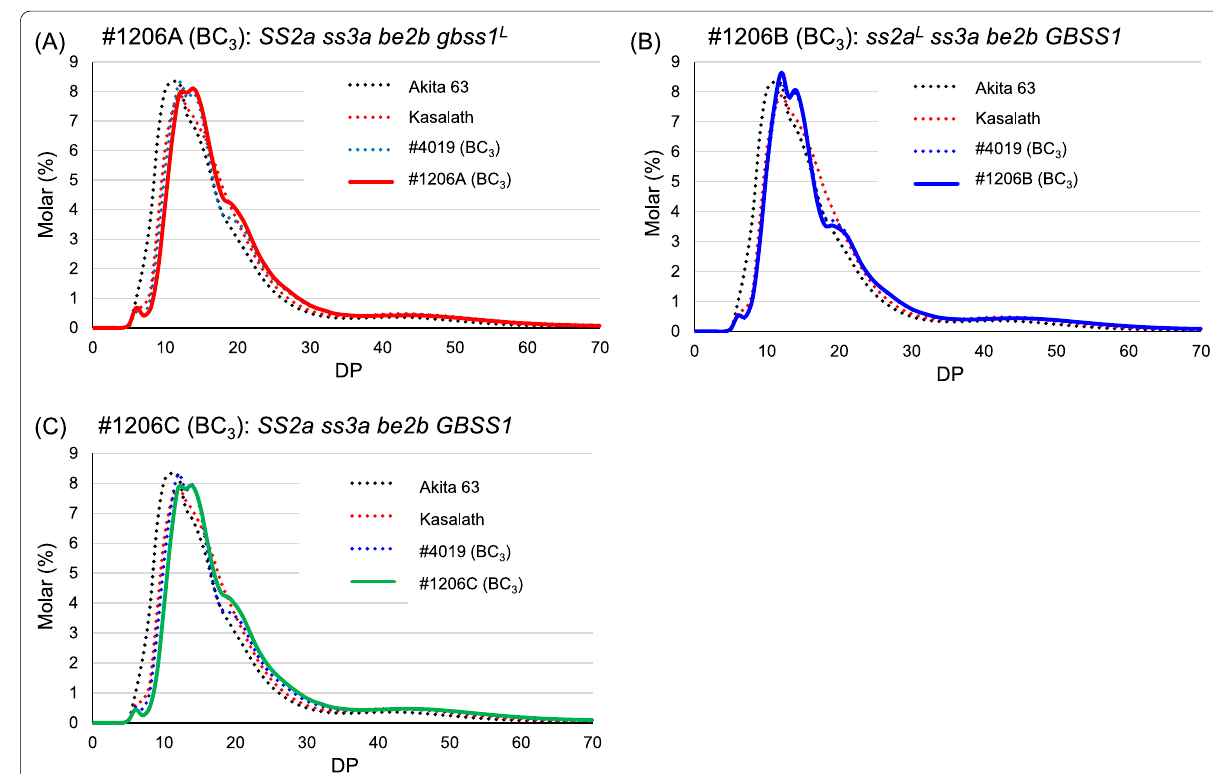
Fig. 5 Comparison of chain length distribution patterns of endosperm amylopectin in #1206 (BC 3 ) lines with those in Akita 63, Kasalath, and #4019 (BC 3 ). a–c Chain length distribution patterns of #1206A (BC 3 ) ( a ), #1206B (BC 3 ) ( b ), and #1206C (BC 3 ) ( c ). Typical patterns obtained in one of at least three replicates are